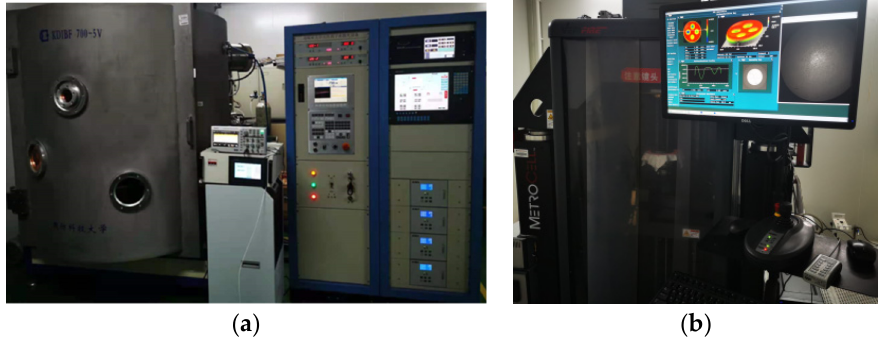
Figure 4. Experimental equipment: ( a ) processing equipment; ( b ) measuring equipment.